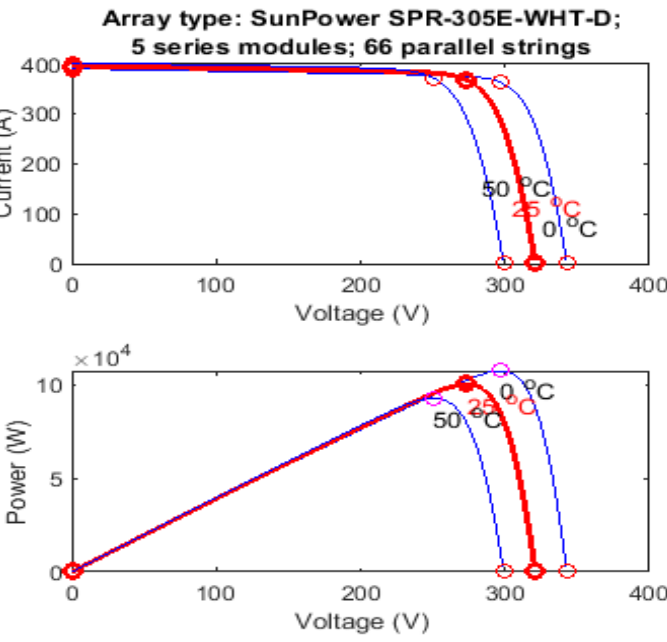
Figure 1. V-I characteristics of a PV cell.